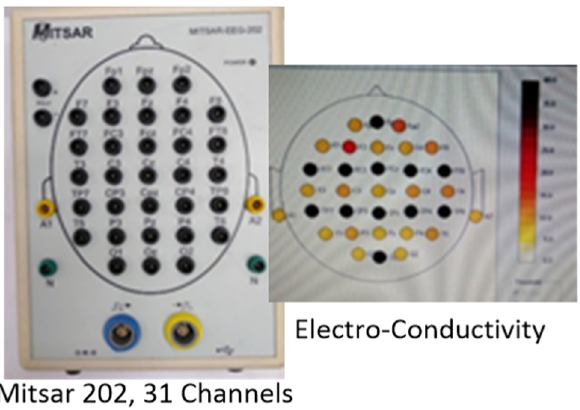
Figure 1: EEG instrument for experiment.